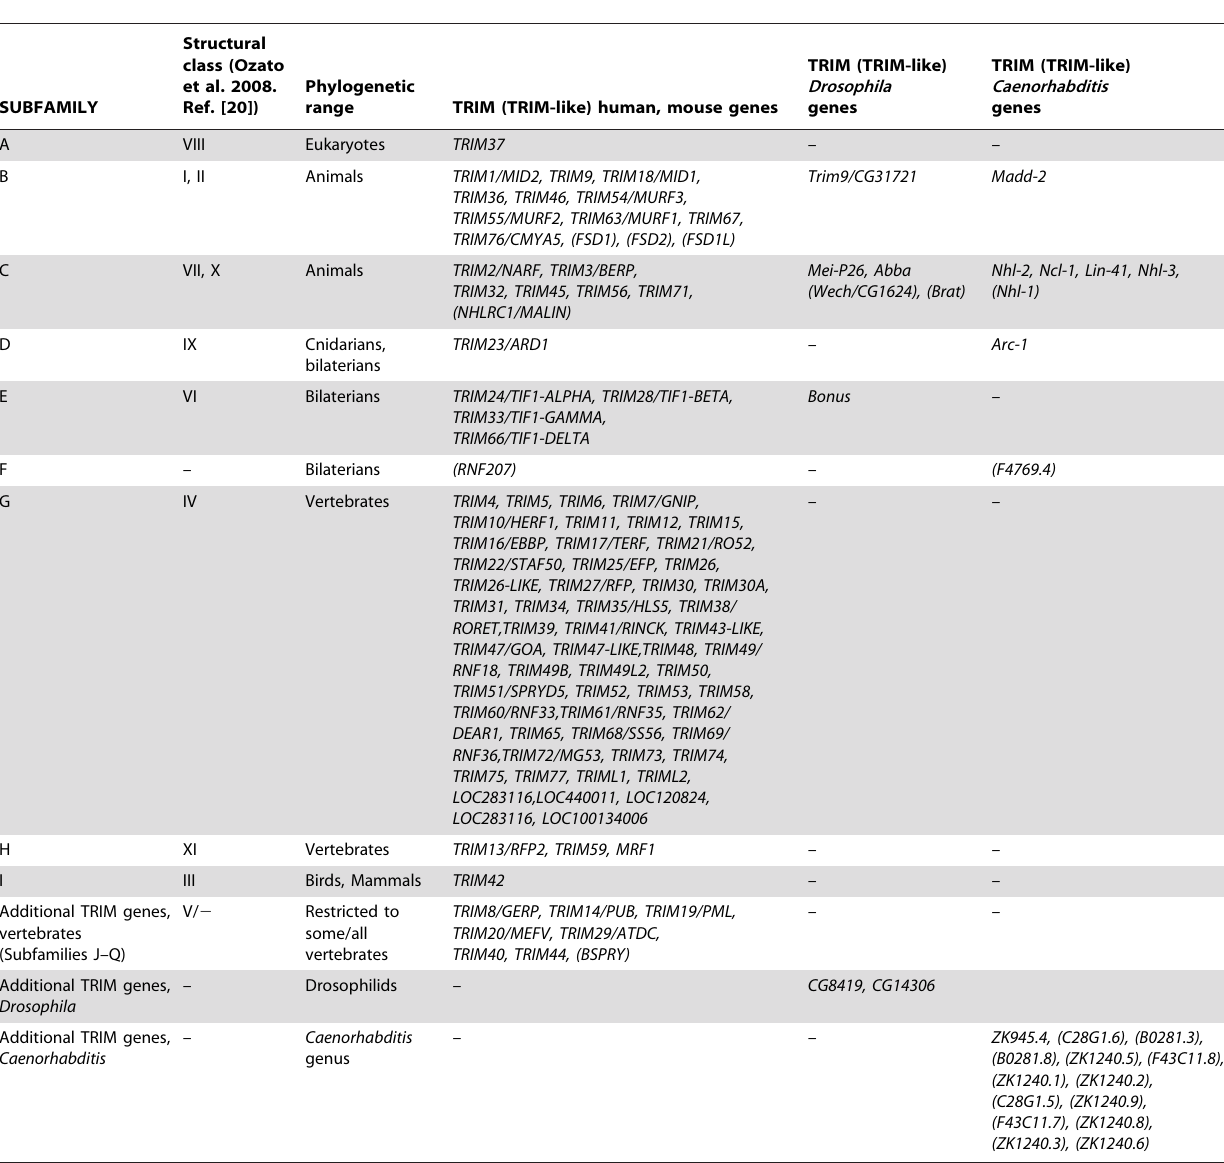
Table 1. Classification of TRIM and TRIM-like proteins (these last ones, between parenthesis).